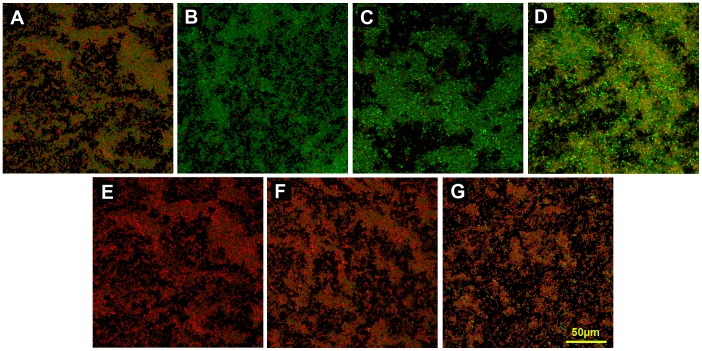
CLSM images showed the effects of antibiotics in combination with nisin on E. faecalis ATCC 29212 biofilms.(A) 512 mg/L penicillin; (B) 512 mg/L ciprofloxacin; (C) 512 mg/L chloramphenicol; (D) 400 U/ml nisin; (E) 512 mg/L penicillin and 400 U/ml nisin; (F) 512 mg/L ciprofloxacin and 400 U/ml nisin; (G) 512 mg/L chloramphenicol and 400 U/ml nisin. Bacteria with intact cell membranes are stained fluorescent green, whereas bacteria with damaged cell membranes are stained fluorescent red. All images were shown at 200× magnification and were collected using a Carl Zeiss CLSM.